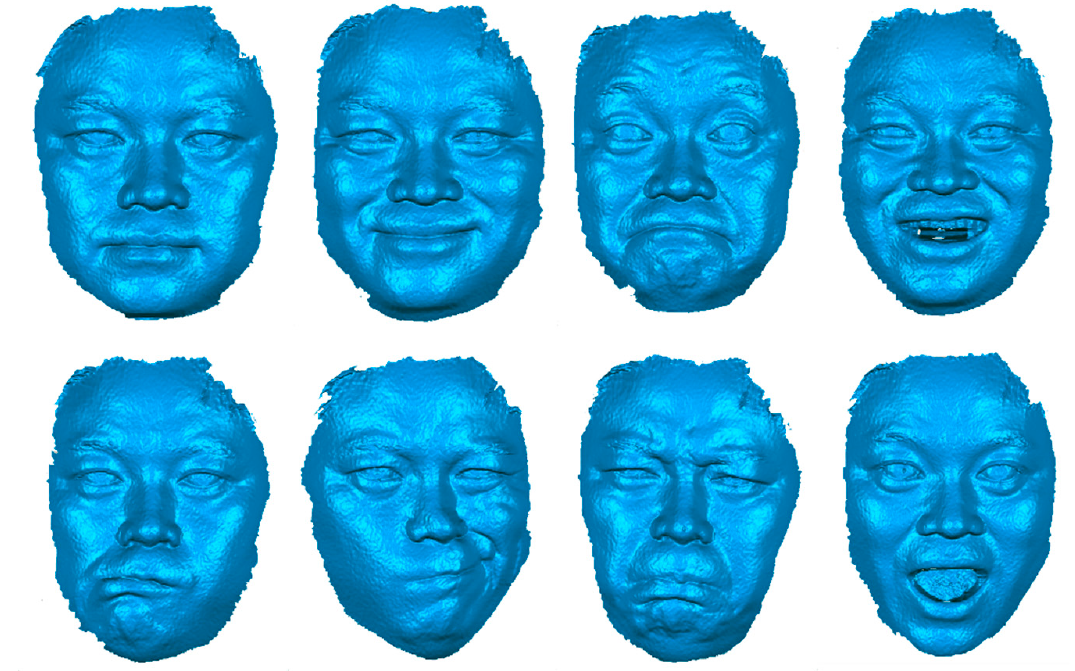
Figure 16. Three-dimensional reconstruction results of the author’s various expressions when N = 12 the speckle stereo image pairs. Table 1. Minimal error statistics and computation time of measuring a face mask (Unit: mm).